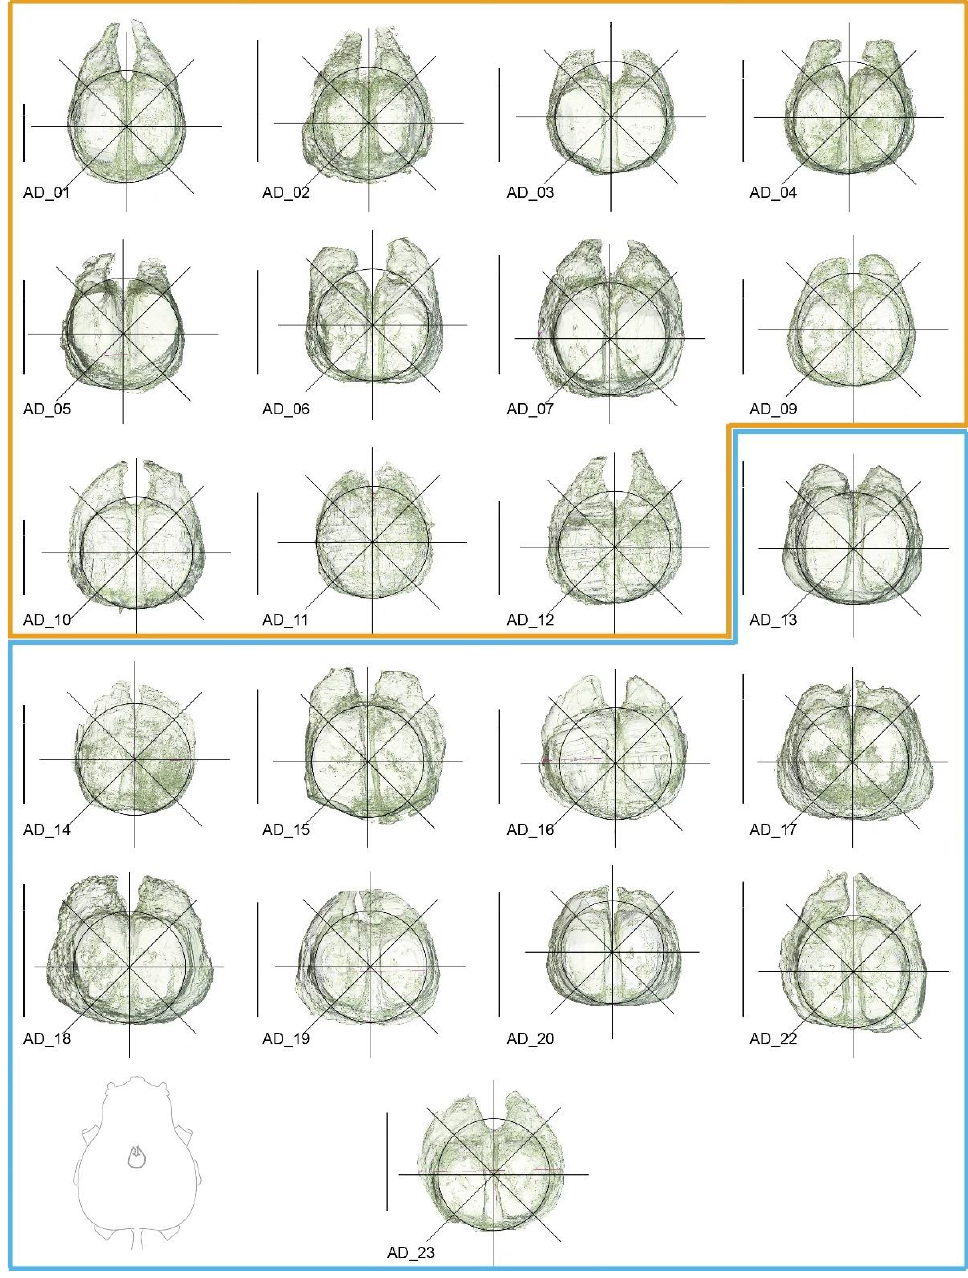
Figure A1. Volume reconstructions of Araneus diadematus brains in dorsal view. Fresh material is marked in dark yellow and legacy material in blue. Landmarks were placed on the crossing of the lines and the edge of the reconstruction following the template in Figure 2. Line drawing in the lower left corner shows the brain in relation to the cephalothorax in dorsal view. Scale bars = 0.5 mm.